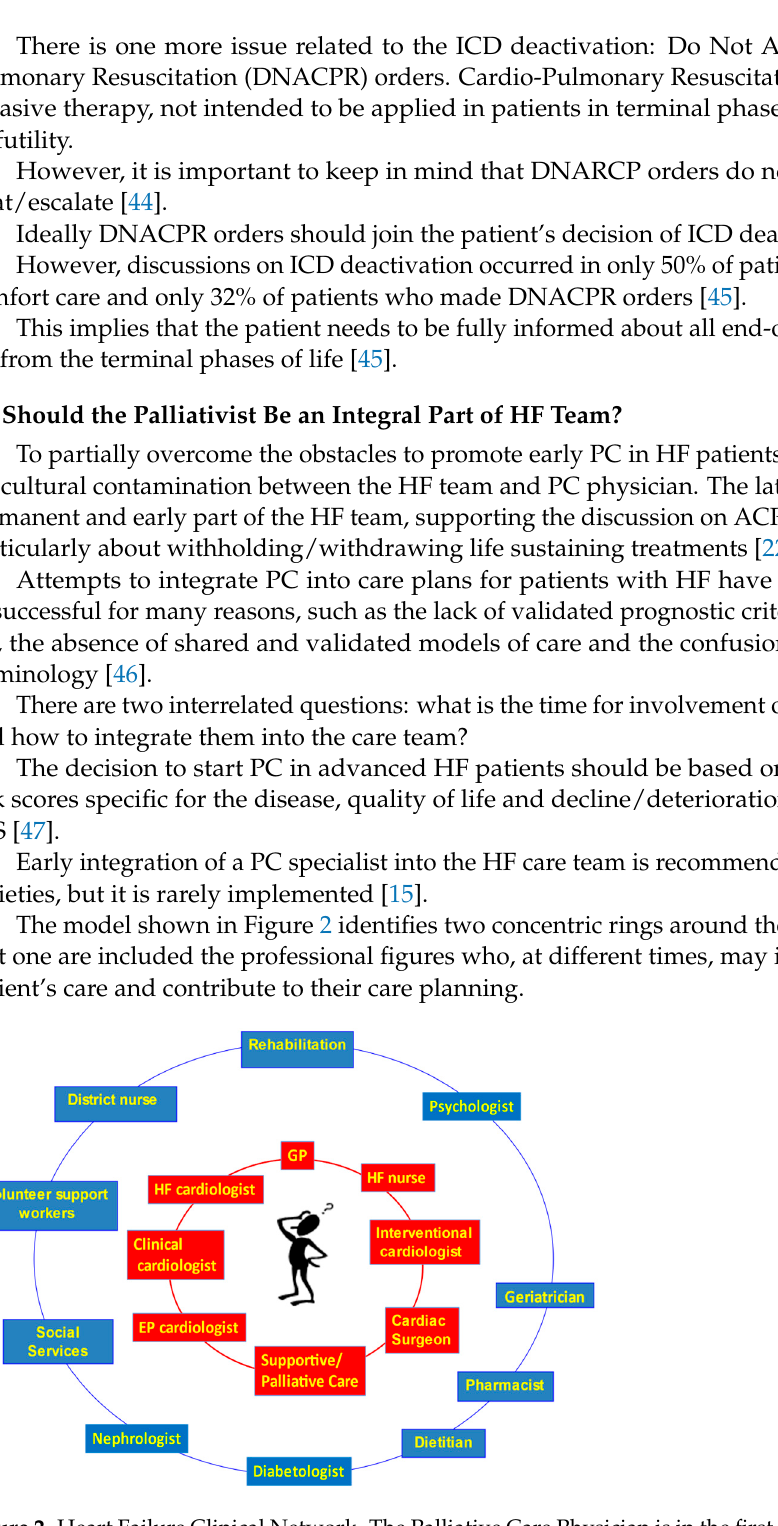
Figure 2. Heart Failure Clinical Network. The Palliative Care Physician is in the first ring surrounding the patient. GP: General Practitioner. EP: Electrophysiology HF: Heart Failure.